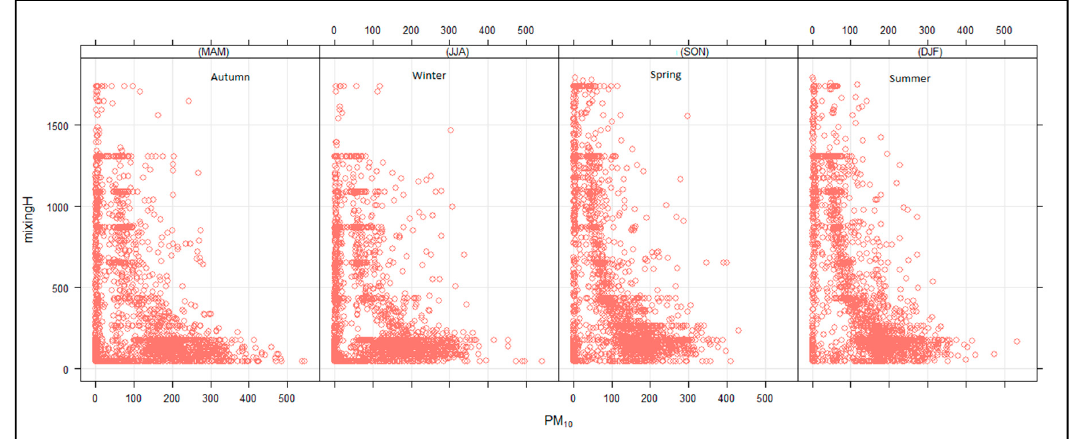
Figure 12. Relationship between PM 10 (µg.cm − 3 ) and mixing height (m) for autumn, winter, spring and summer.